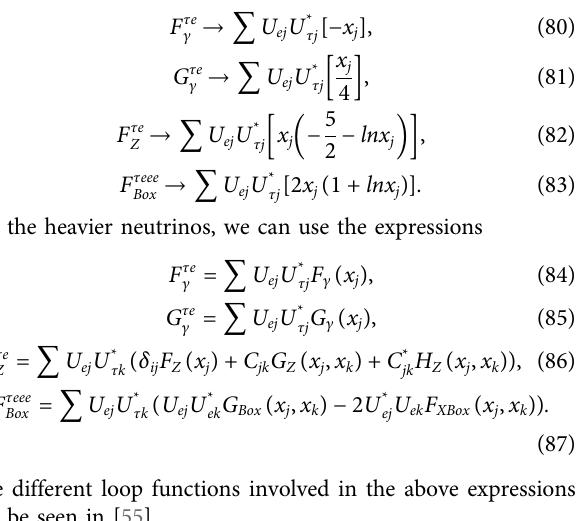
TABLE 5 | Predictions of the model on different parameters. The value of m ββ is taken from the KamLAND-ZEN experiment [62] and (cid:21) m i from latest Planck data